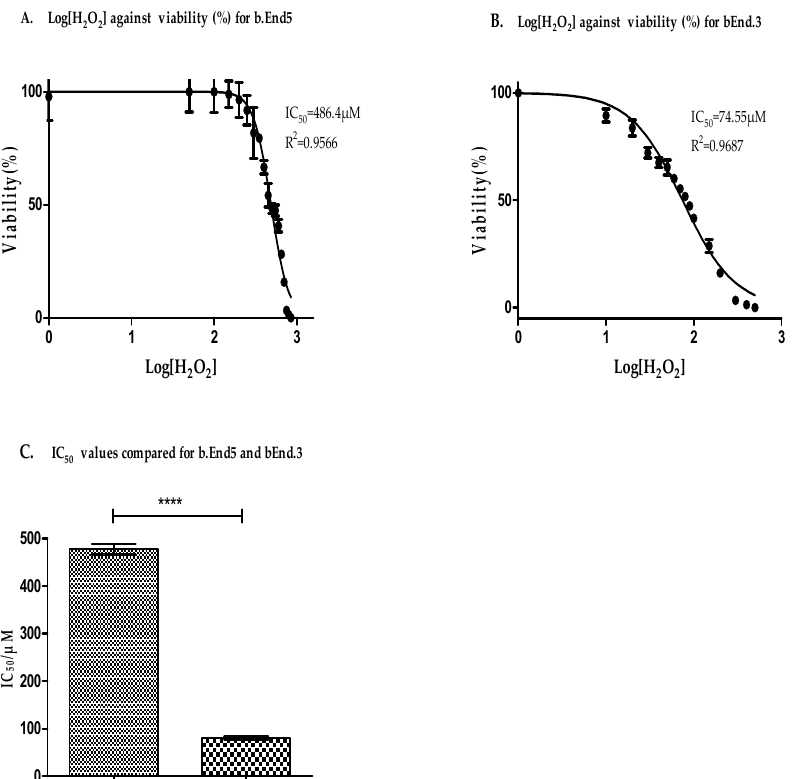
Figure 4. A non-linear regression analysis of logarithmic values of [H 2 O 2 ] against normalized viability was used to determine the hydrogen peroxide concentration that caused 50% inhibition of cell viability in b.End5 cells. Cells were exposed to [H 2 O 2 ] that ranged between 0 (control) and 850 µ M for 24 h in flat-bottom transparent 96-well plates. Viability changes correlated to the absorbance measured at 450 nm from each well following incubation with XTT reagent for 4 h. ( A ) Results showed IC 50 for b.End5 cell as equivalent of 486.4 µM at r 2 = 0.9566. ( B ) Data for bEnd.3 cells was obtained by exposing cultured bEnd.3 cells to [H 2 O 2 ] ranged from 0 (control) to 500 µM and non-linear regression analysis done as described above. Results showed IC 50 for bEnd.3 cell to be 74.55 µM at r 2 = 0.9687 µM. ( C ) Graph of the IC 50 values for the b.End5 compared with the same values for the bEnd.3 cells (annotation * denotes statistically significant difference between the values shown). IC 50 values for b.End5 and bEnd.3 cells were statistically compared using the Student ′ s t test. The analyzed data showed that the IC 50 value was significantly higher for b.End5 cell than for the bEnd.3 cell ( p <